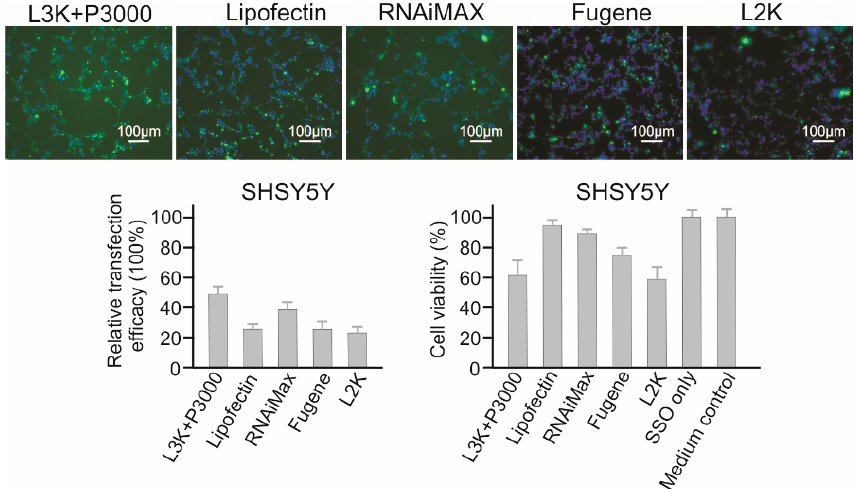
Figure 4. In vitro transfection efficiency and cytotoxicity of different transfection reagents in SHSY5Y cells. L3K: Lipofectamine 3000, L2K: Lipofectamine 2000.